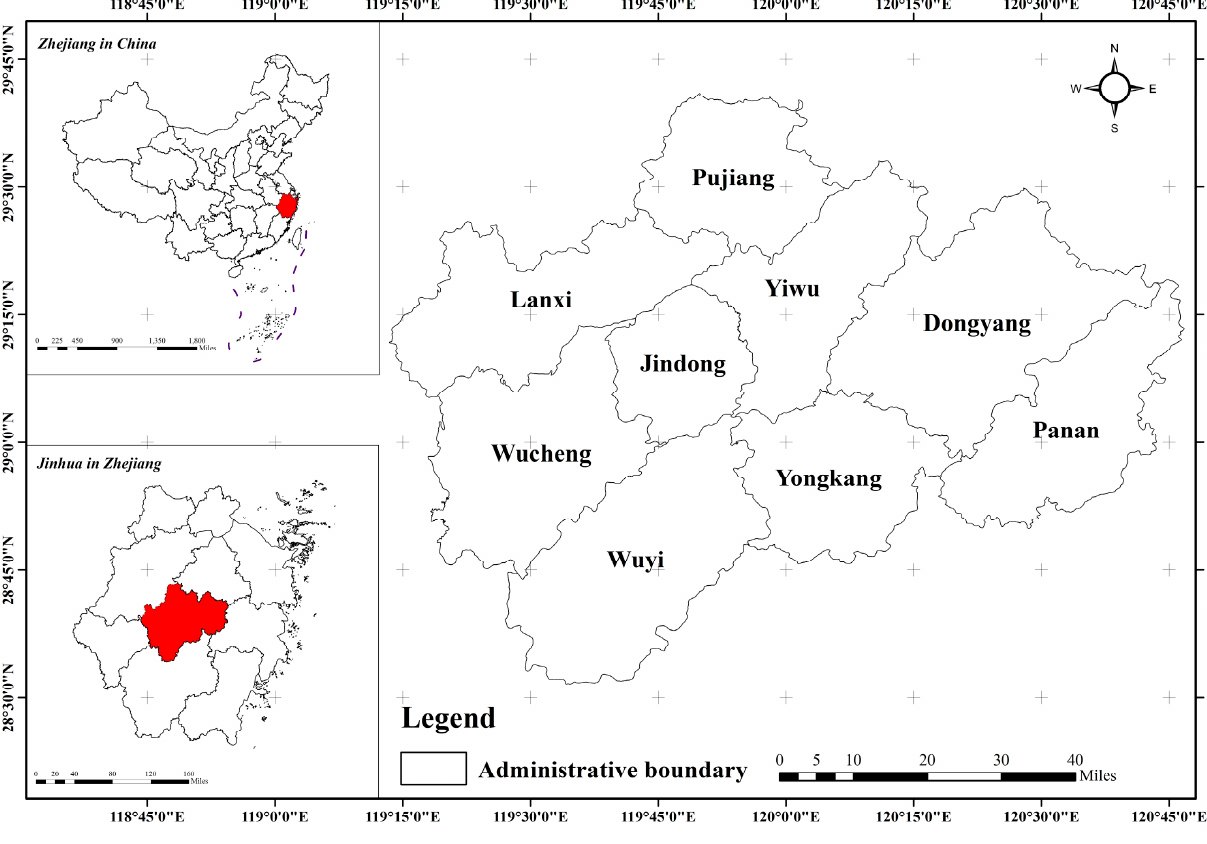
Figure 1. Location and topography of the study area.